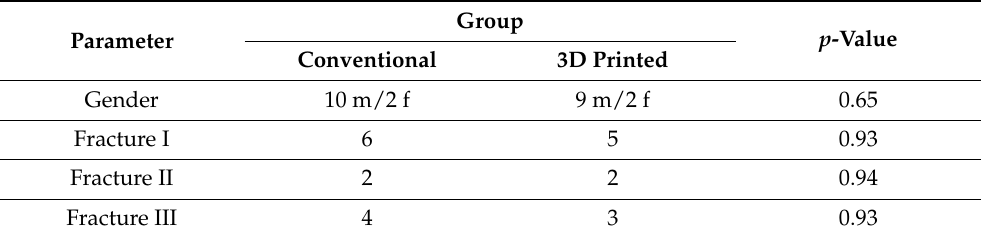
Table 1. Gender and fracture type distributions in the study groups: fracture I—both-column fracture; fracture II—transverse plus posterior wall fracture; fracture III—posterior column plus posterior wall fracture. Group p -Value Parameter Conventional 3D Printed Gender 10 m/2 f 9 m/2 f 0.65 Fracture I 6 5 0.93 Fracture II 2 2 0.94 Fracture III 4 3 0.93